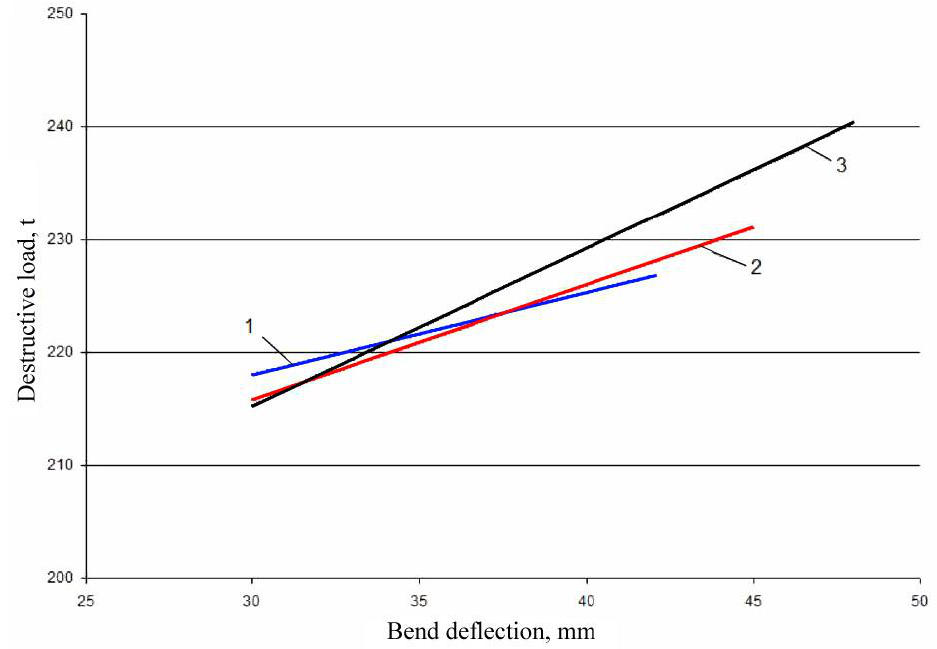
Figure 9. Strength and ductility of welded joints tested for static bending: 1 — continuous melting;